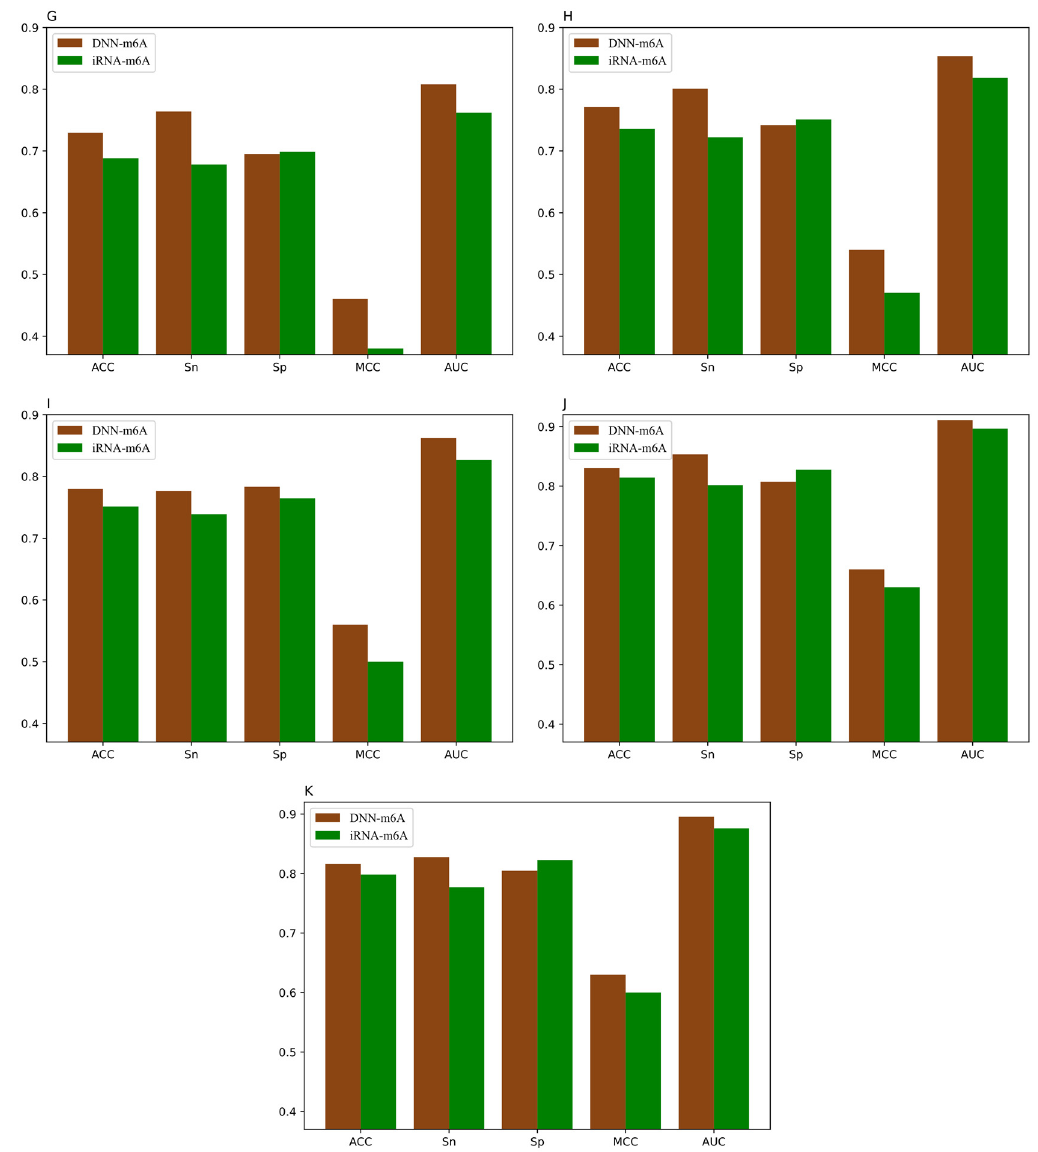
Figure 8. Performance of iRNA-m6A and DNN-m6A on eleven tissues’ independent datasets ( A ) H_B, ( B ) H_K, ( C ) H_L, ( D ) M_B, ( E ) M_H, ( F ) M_K, ( G ) M_L, ( H ) M_T, ( I ) R_B, ( J ) R_K, and ( K ) R_L.